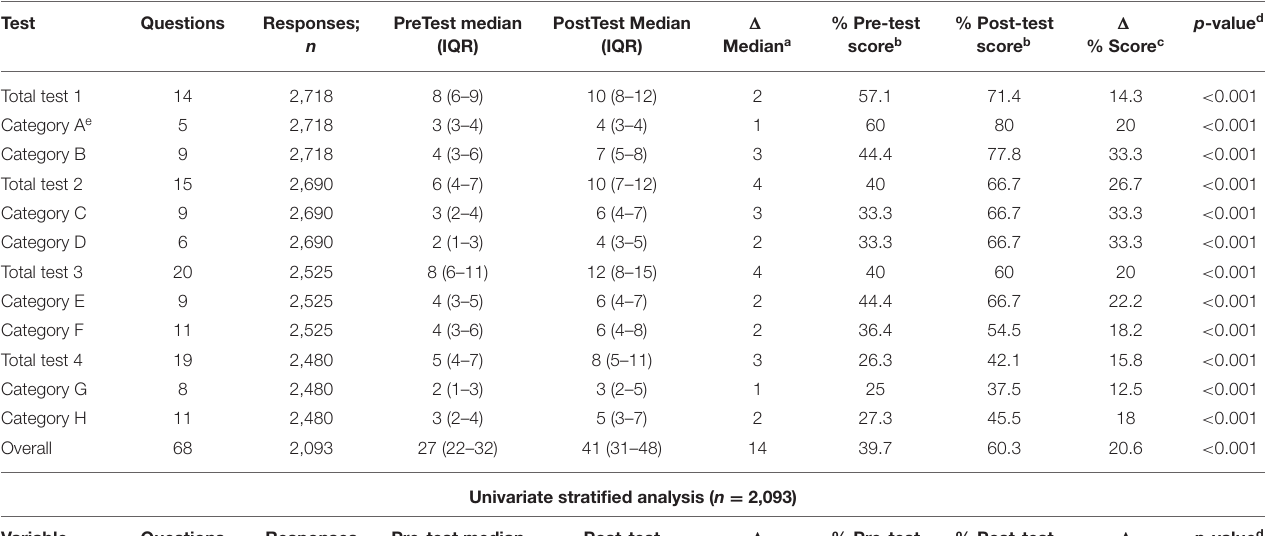
TABLE 3 | Comparison and univariate analysis of pre-test and post-test knowledge using Multiple Choice Questions (MCQ) format questionnaires. Comparison of pre-test and post-test